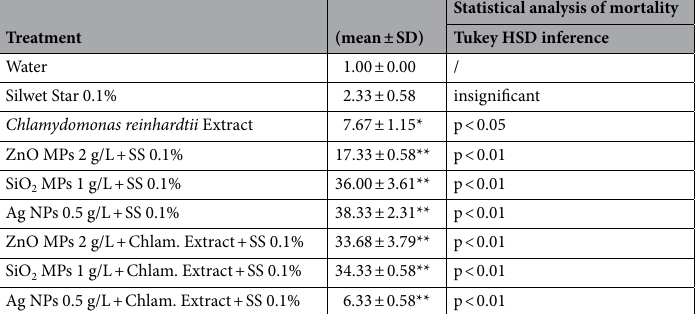
Statistical analysis of